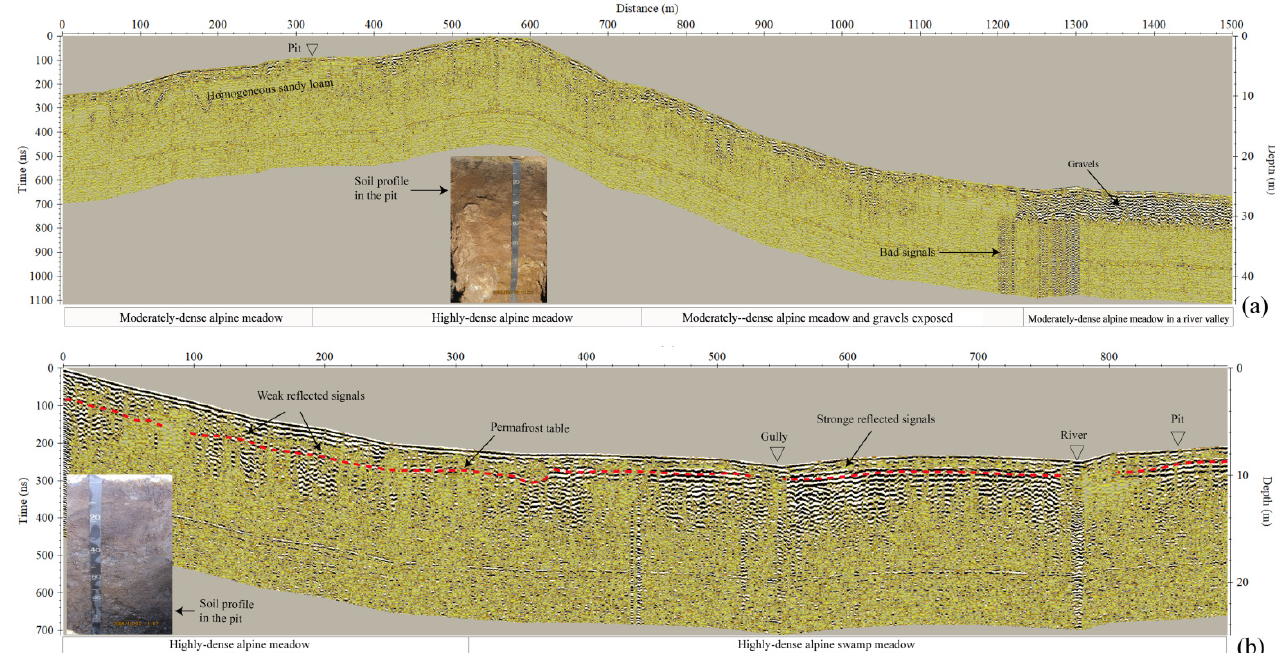
Figure 4. Comparison of ground-penetrating radar (GPR) images between permafrost and seasonal frozen ground. ( a ) A typical seasonal frozen ground profile (P029, altitude: 3993–4093 m). The reflected signals are weak at 0–1200 m in the image. There is a uniform formation made up of sandy loam and no permafrost here, which is proved by a pit. The upper part of the soil profile in this pit is wet, and the lower part is dry. The latter half of the GPR image (after 1200 m) has strong reflected signals, but their continuity is poor. Considering that it is located in a river valley, these signals are interpreted as gravels brought by river alluvium. ( b ) A typical permafrost profile (P041, altitude: 4578–4617 m). In the profile, there is a continuous and clear in-phase reflection axis, which represents the existence of the permafrost table. The soil profile of a pit shows that the permafrost has high ice content and is located below a 1.2 m depth. According to this depth and the position of the reflection axis, the adopted wave velocity can be estimated. The ground temperature (at 10 m) observed in an adjacent borehole was approximately − 2.5 °C in November 2010.